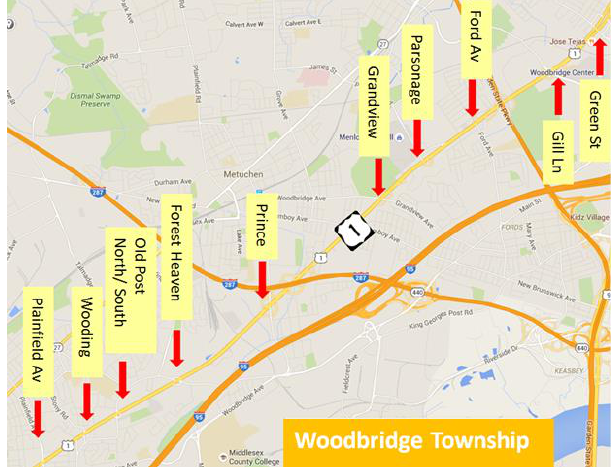
Figure 6. ITSAS test-bed corridor in Woodbridge, New Jersey.